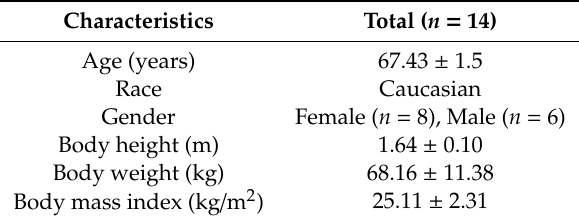
Table 2. Subject